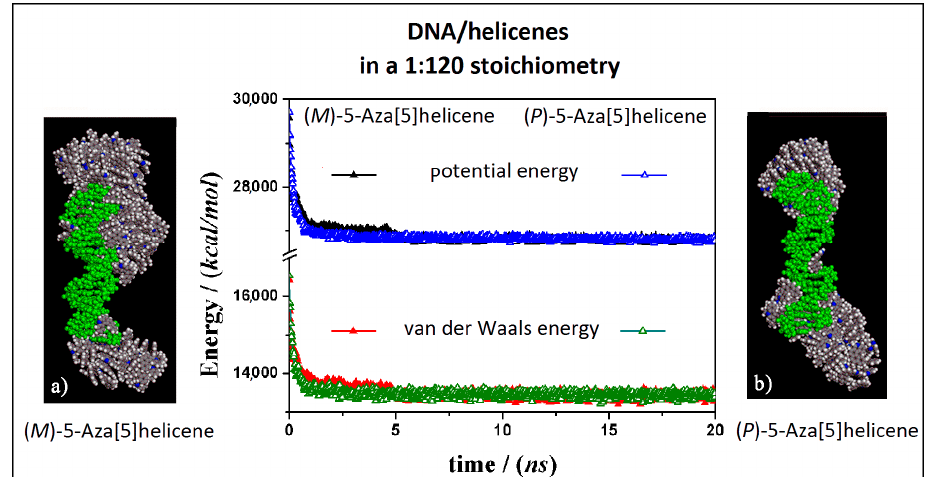
Figure 7. Optimized geometries of ( M )-HA on the left ( a ) and ( P )-HA on the right ( b ) after energy minimization of the conformation assumed by the system at the end of MD run considering enantiopure compounds in a 1:120 stoichiometry. In the central panel the potential energy and the van der Waals contribution calculated during MD run lasting 20 ns for the ( M )-HA (full symbols, black and red respectively) and the ( P )-HA (empty symbols, black and red respectively). The color code is the same as in Figure 5.